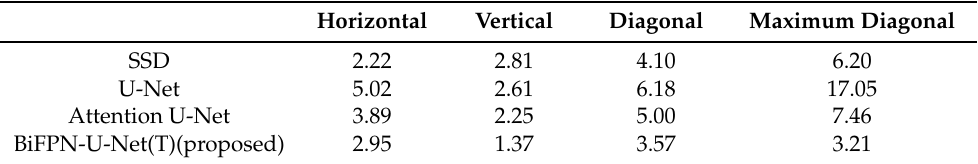
Table 4. Root-mean-square error (RMSE) between the actual distance and the predicted distance for hyoid bone movement